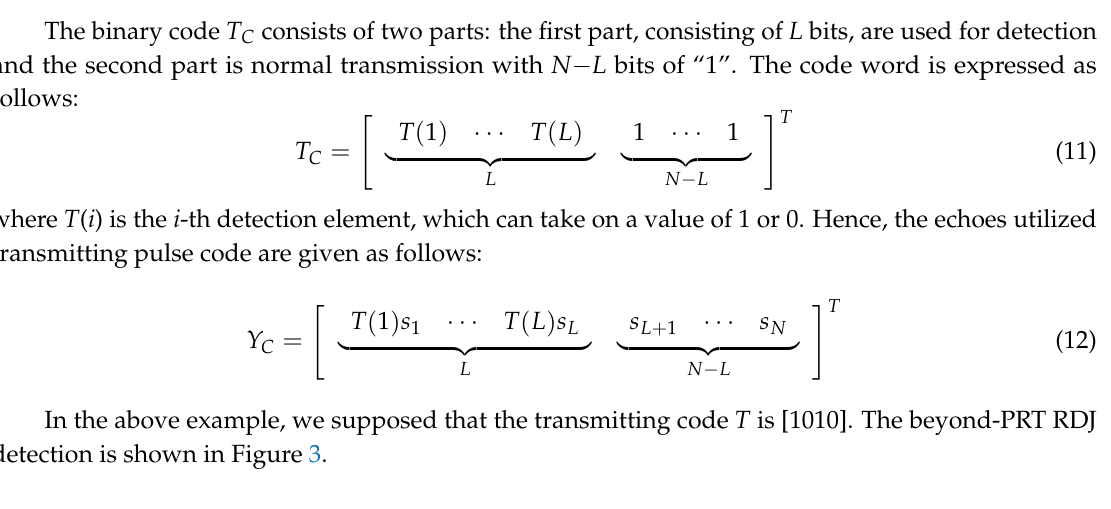
Figure 2. An example of transmitting pulse encoding for beyond-PRT RDJ